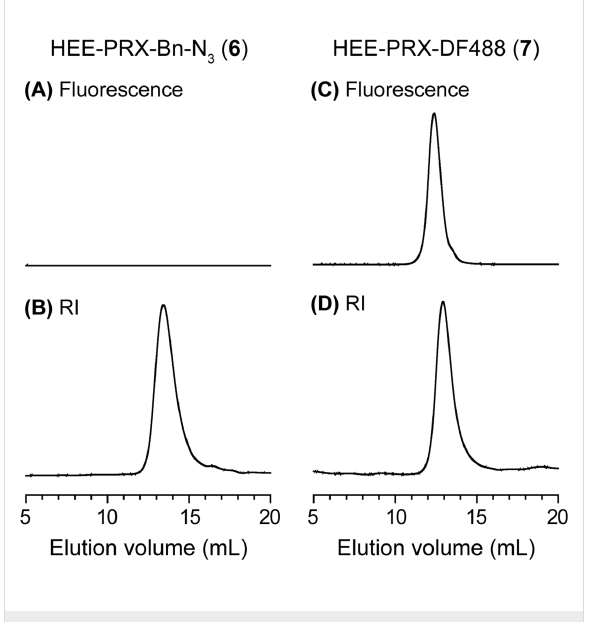
Figure 4: SEC charts of the HEE-PRX-Bn-N 3 ( 6 ) (A, B) and the HEE- PRX-DF488 ( 7 ) (C, D) monitored with fluorescence detector (excita- tion wavelength: 488 nm, emission wavelength: 515 nm) (A, C) and refractive index (RI) detector (B,